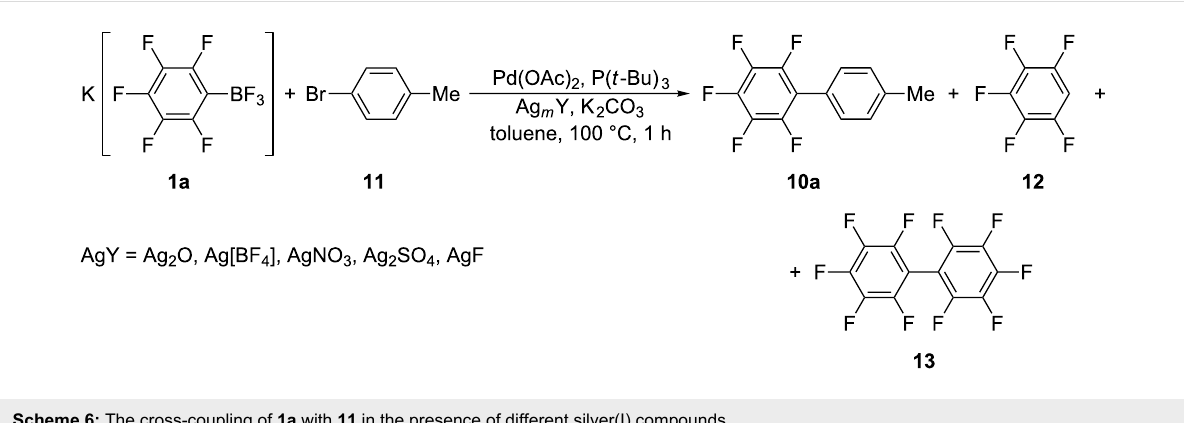
Scheme 6: The cross-coupling of 1a with 11 in the presence of different silver(I) compounds.